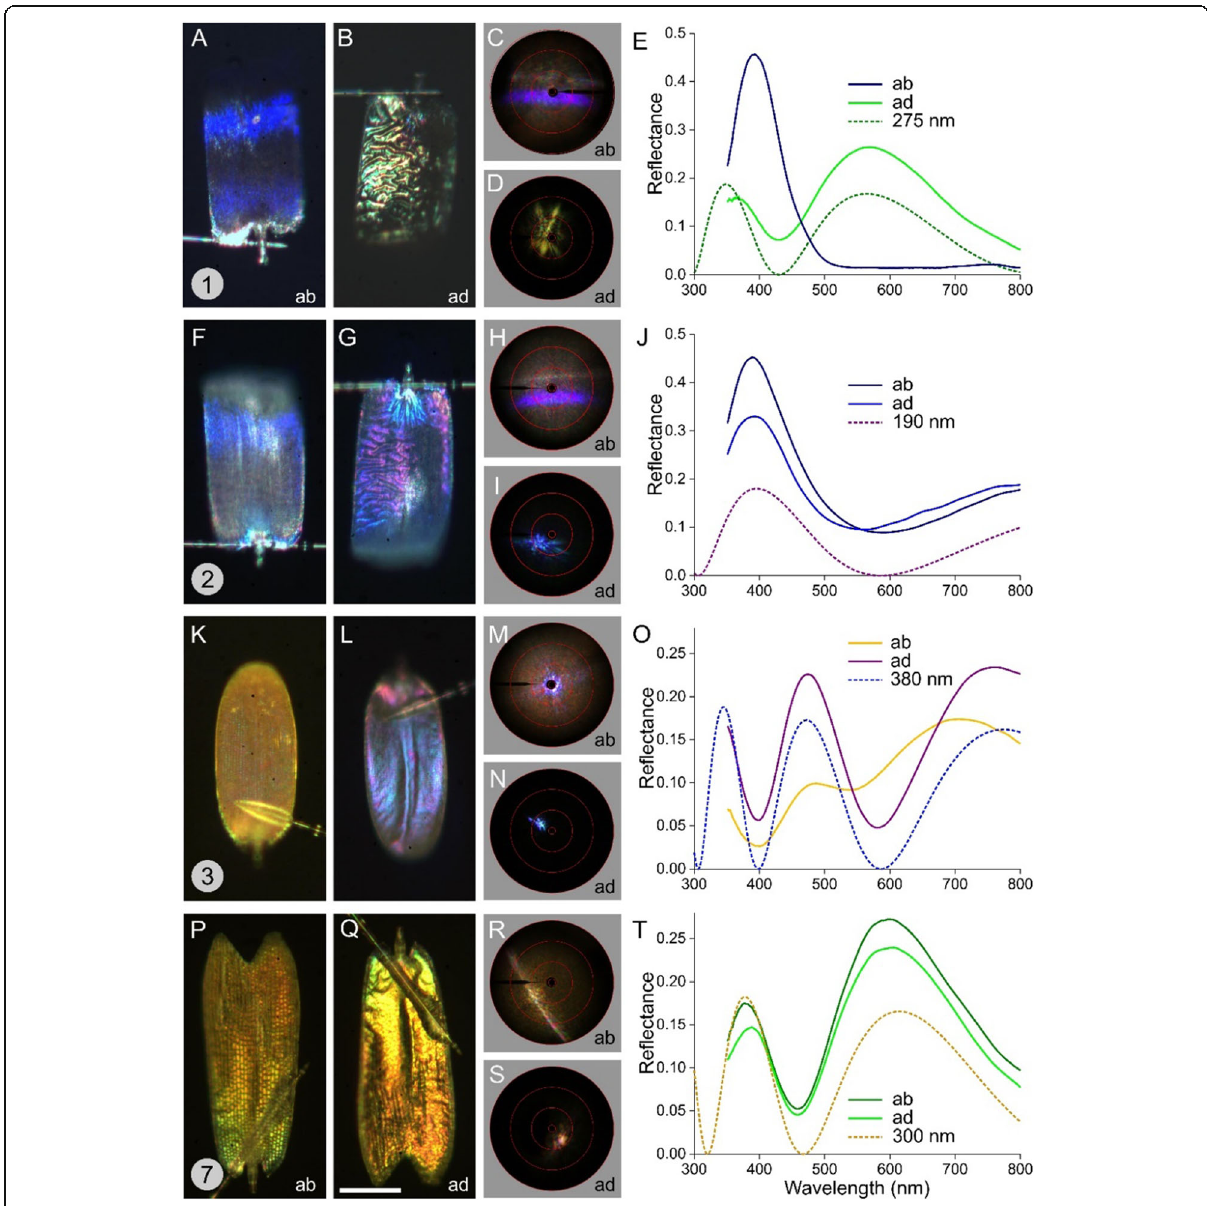
Fig. 3 Light micrographs, scatterograms and reflectance spectra of isolated wing scales. a - e Blue scale. f - j White scale. k - o Orange-yellow scale of the dorsal forewing. p - t Orange-yellow scale of the ventral forewing. a , b , f , g , k , l, p , q Epi-illumination light micrographs of the abwing side (1st column) and adwing side (2nd column); scale bar: 50 nm. The numbers 1 – 3 and 7 in a , f , k , and p correspond with the numbered areas in Fig. 1b, e. 3rd column: Scatterograms of the abwing and adwing side; the red circles indicate scattering angles of 5°, 30°, 60°, and 90°. 4th column: Reflectance spectra of the ab- and adwing sides and of chitinous thin films with thicknesses of 275, 190, 380, and 300 rotating the wing around an axis parallel to the blue The lattice of scales on the wing bands, the transition area shifts over the scales. In nat- With the gained insight into the optics of single scales, ural conditions, the scales ’ curvature is presumably used we can understand the coloration of the butterfly ’ s wings to radiate the blue color into a large spatial angle. The when covered by the intact lattice of scales. Epi- melanin pigment of the black-blue scales effectively ab- illumination microscopy of a transition area with blue sorbs scattered stray light, creating a contrasting back- and white scales on the dorsal forewing demonstrates ground for the reflection of the blue color (see also Fig. that both scale types have the same blue band but on a 3e). As the white-blue scales lack pigmentation, part of black or white background, respectively (Fig. 4a). When